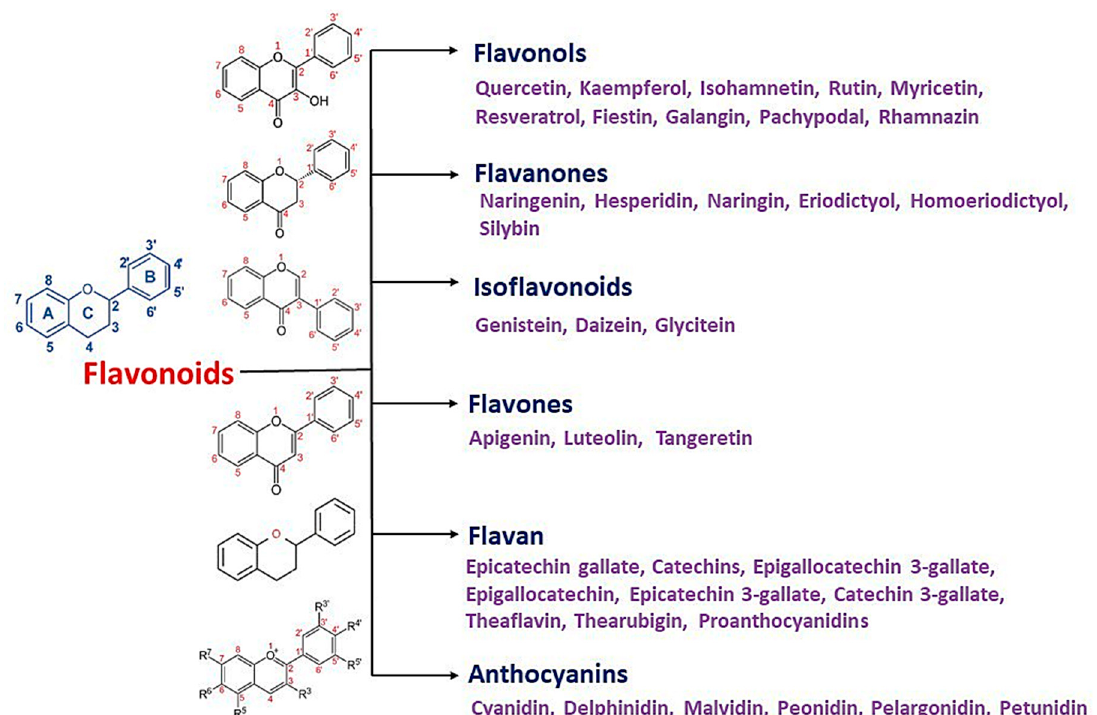
Figure 1. Major classes of Flavonoids.